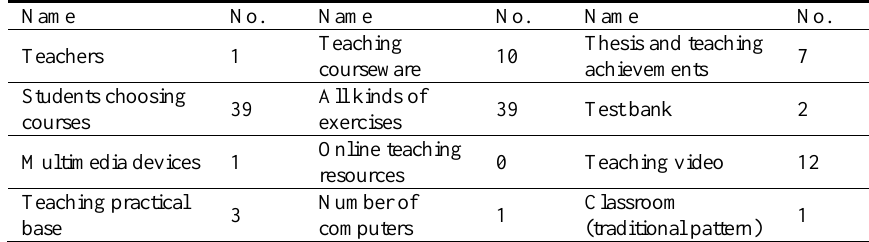
Table 1. The Initial Opening Situation of Visual Communication Design Major and Teaching Resource List